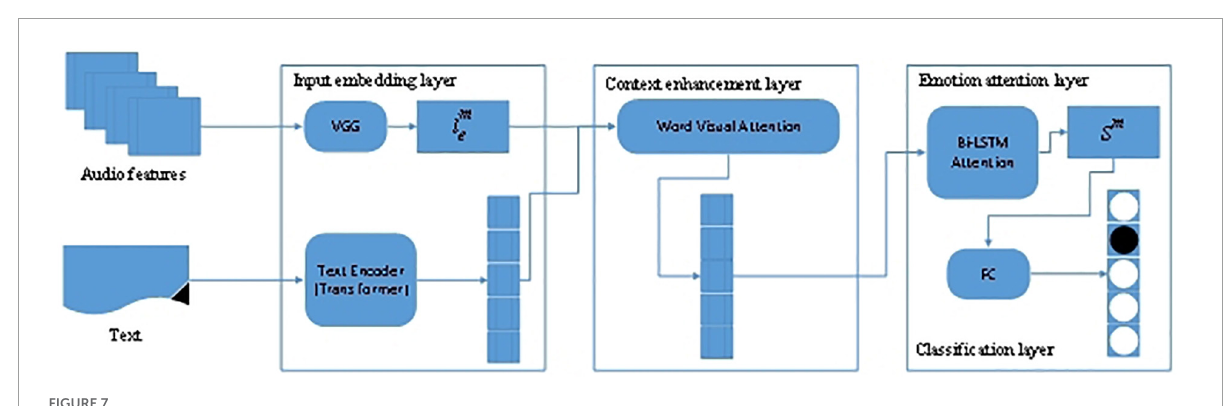
FIGURE6 The framework of the proposed method (Zhu et al., 2019).